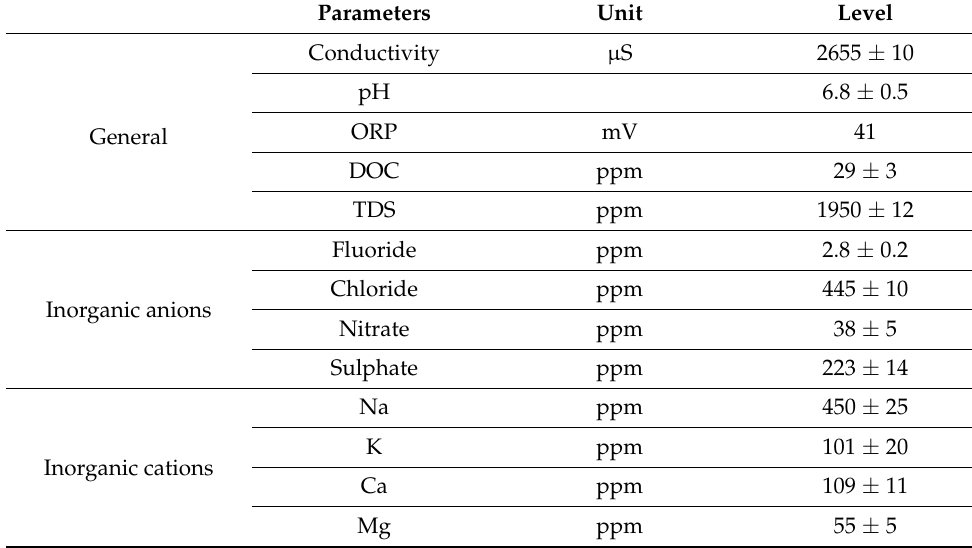
Table 2. Characteristics of the ROC.